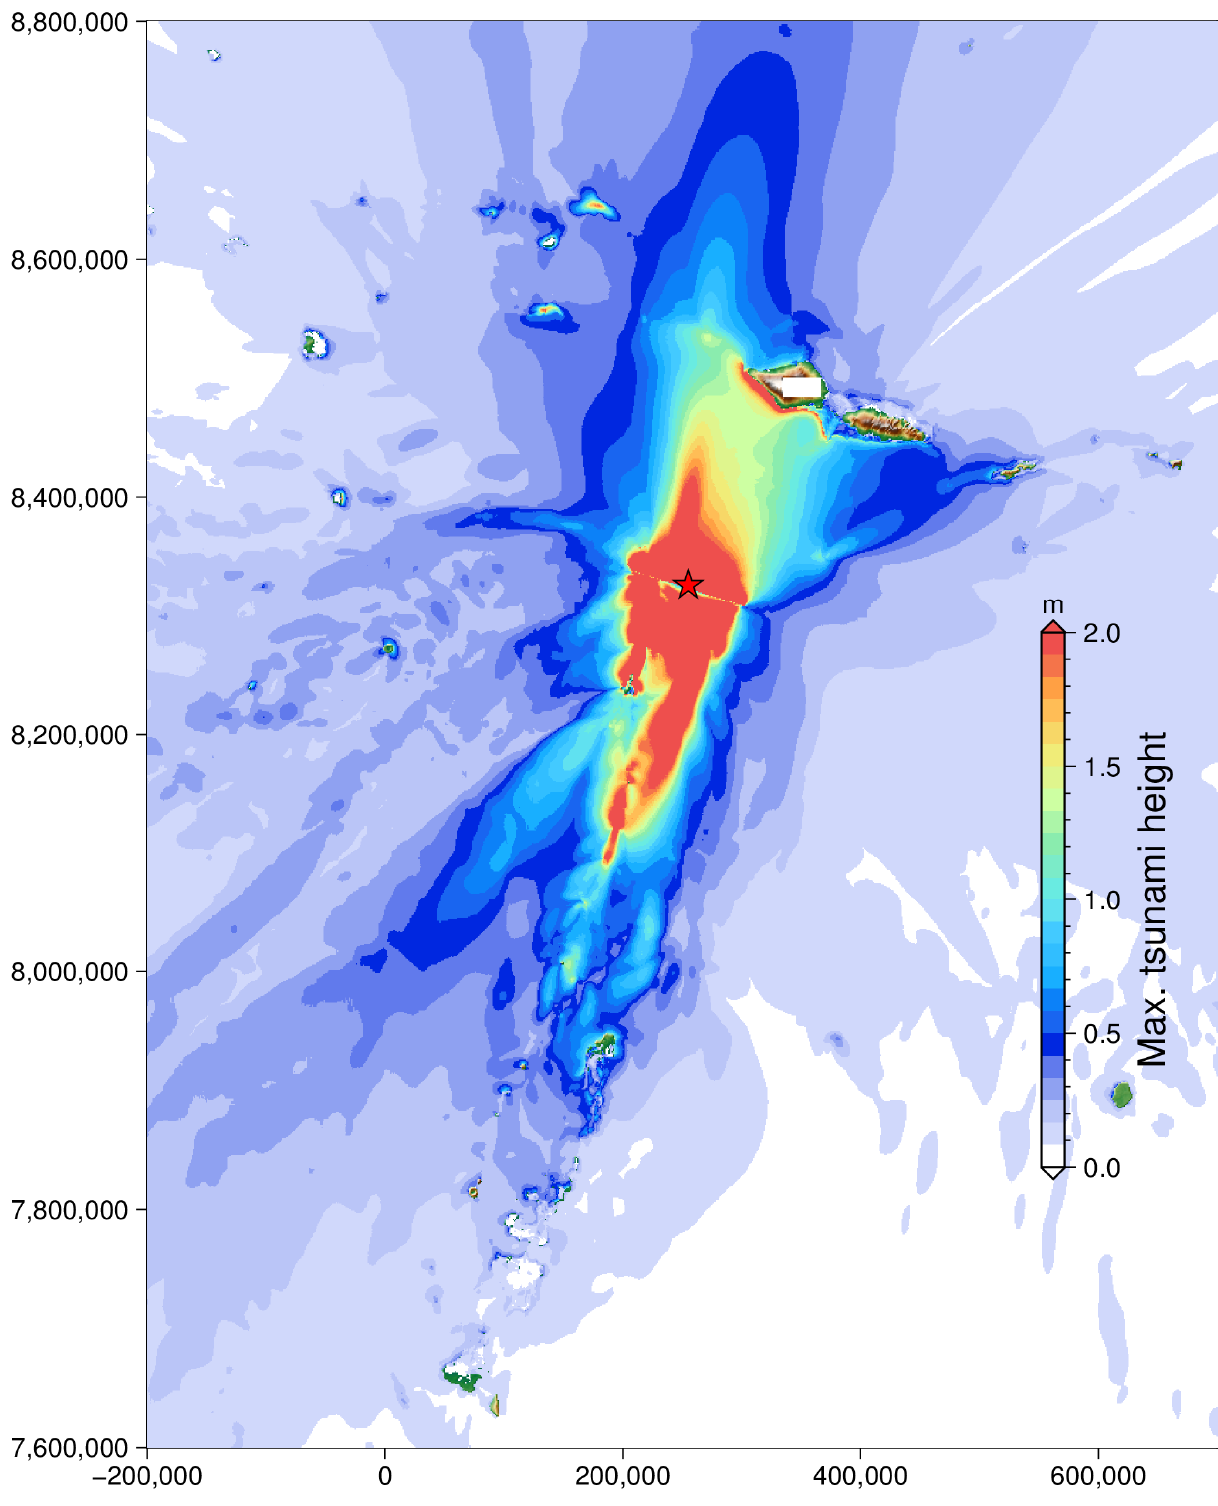
Figure 4. Maximum wave height offshore for the modelled 1917 tsunami.